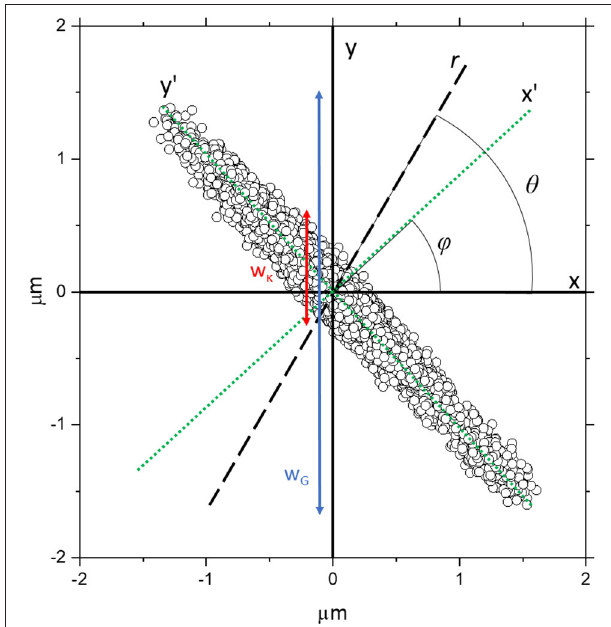
FIGURE 1 | The trajectory obtained from the simulation of a bead confined within a highly asymmetric optical trap, with trap stiffnesses κ x ′ = 1 × 10 − 6 Nm − 1 and κ y ′ = 1 × 10 − 8 Nm − 1 along the x’ and y’ axes, respectively (green dotted lines), which are rotated by an angle φ relative to the Cartesian x and y axes. The black dashed line is an arbitrary direction r along which the analysis is being carried out and it is orientated at an angle θ from the x axis. The red line represents a rough estimate of w κ , the spread of particle coordinates due to the strength of the trap projected along y, whereas the blue line represents w G which is a rough estimate of the spread of particle coordinates projected along y due to the geometry of the